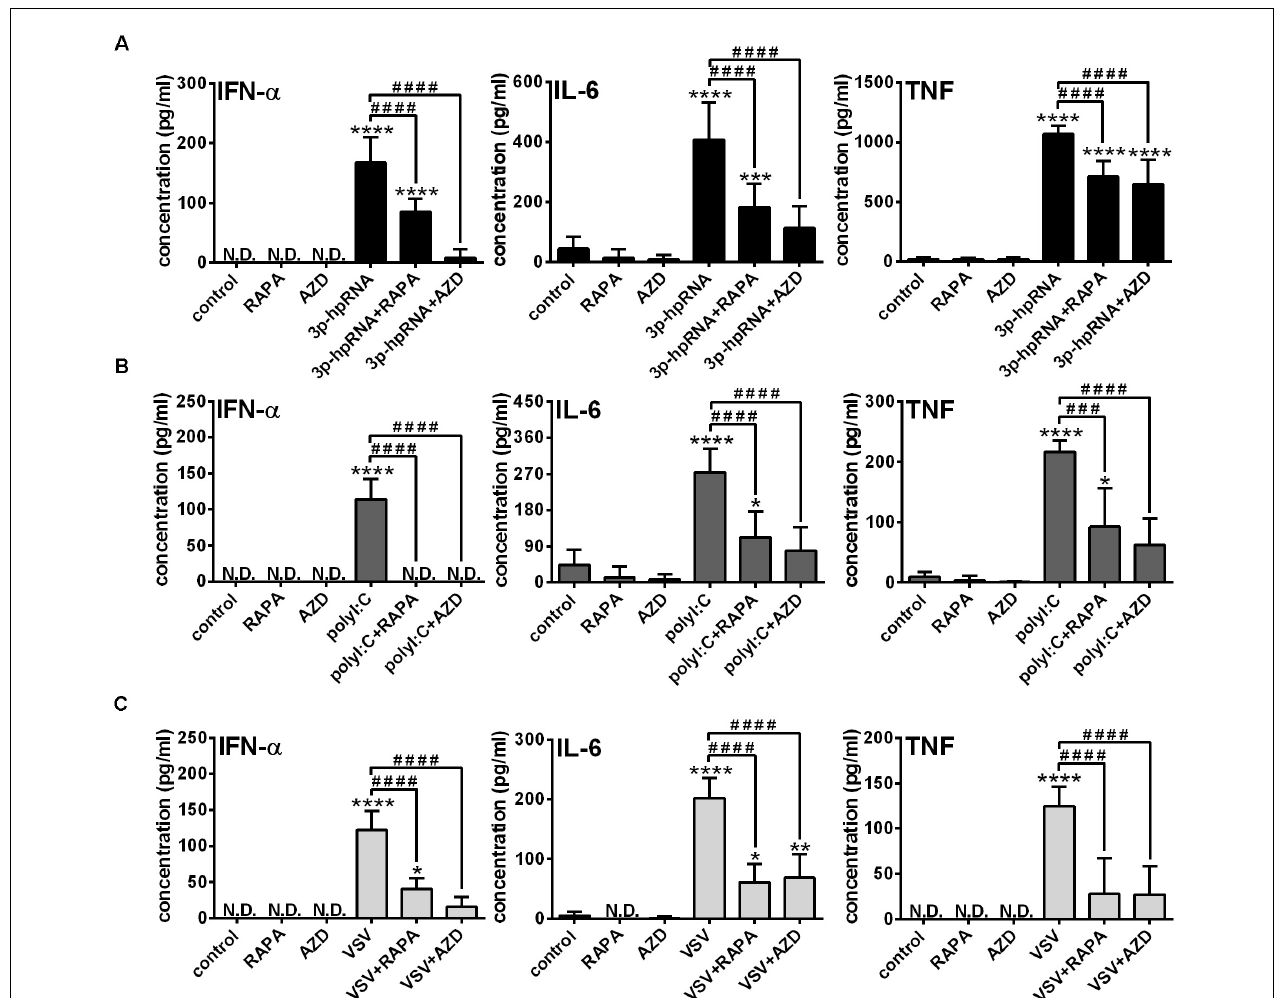
FIGURE 3 | The RLR-mediated production of IFN- α and pro-inflammatory cytokines is decreased upon mTOR blockade in moDCs. Immature moDCs were pre-treated with vehicle control, 100 nM rapamycin (RAPA) or 100 nM AZD8055 (AZD) for 2 h and then stimulated with 3p-hpRNA (0.5 µ g/ml) (A) , polyI:C (1 µ g/ml) (B) or VSV (MOI 1) (C) . (A–C) IFN- α , IL-6 and TNF protein levels were measured by ELISA 24 h after 3p-hpRNA and polyI:C activation as well as 18 h after VSV stimulation. Data are shown as mean ± SD from 5 to 8 independent experiments. * p < 0.05, ** p < 0.01, *** p < 0.01, **** p < 0.0001 vs. control; ### p < 0.001, #### p < 0.0001. ND, not